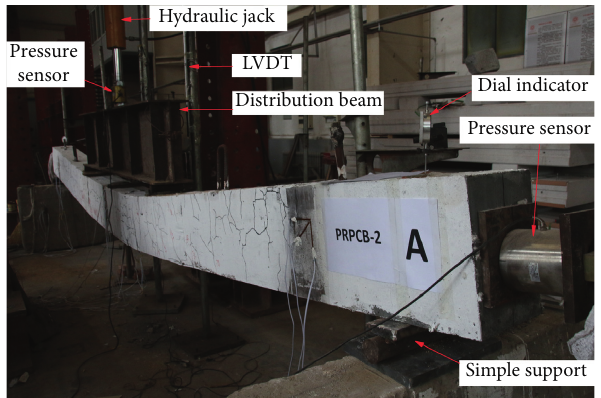
Figure 6: Postfire test